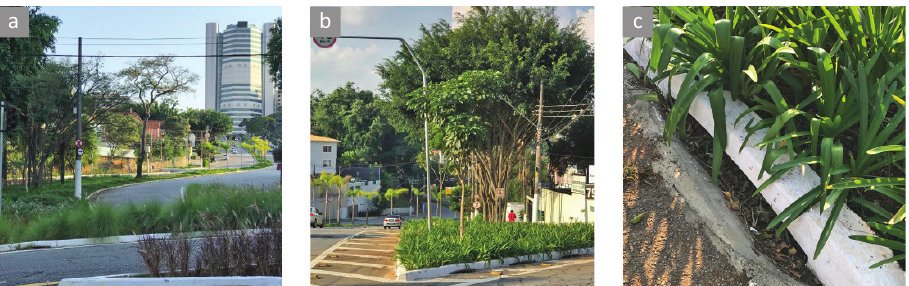
Figure 6. Programa Gentileza Urbana: Interventions in São Paulo; (a) overview of street with rain gardens; (b) a raingarden at the intersection of two streets; (c) kerb detail for water